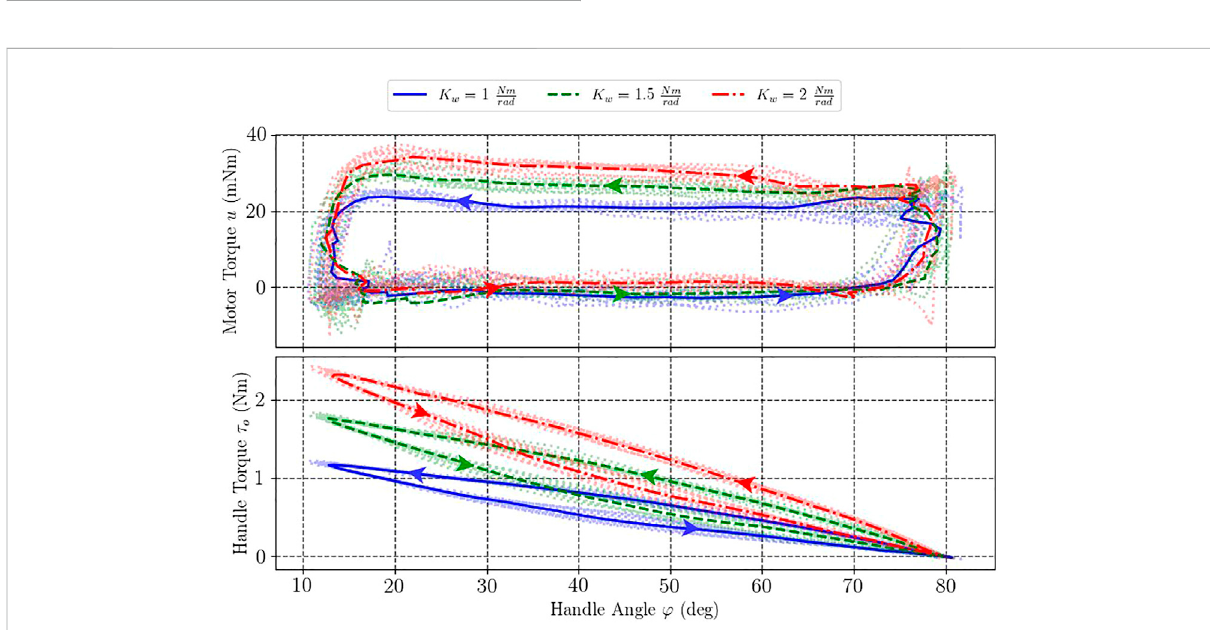
FIGURE 9 Results for haptic virtual wall rendering. Comparison of handle and motor torque values at different stiffness coef fi cients of the virtual wall.